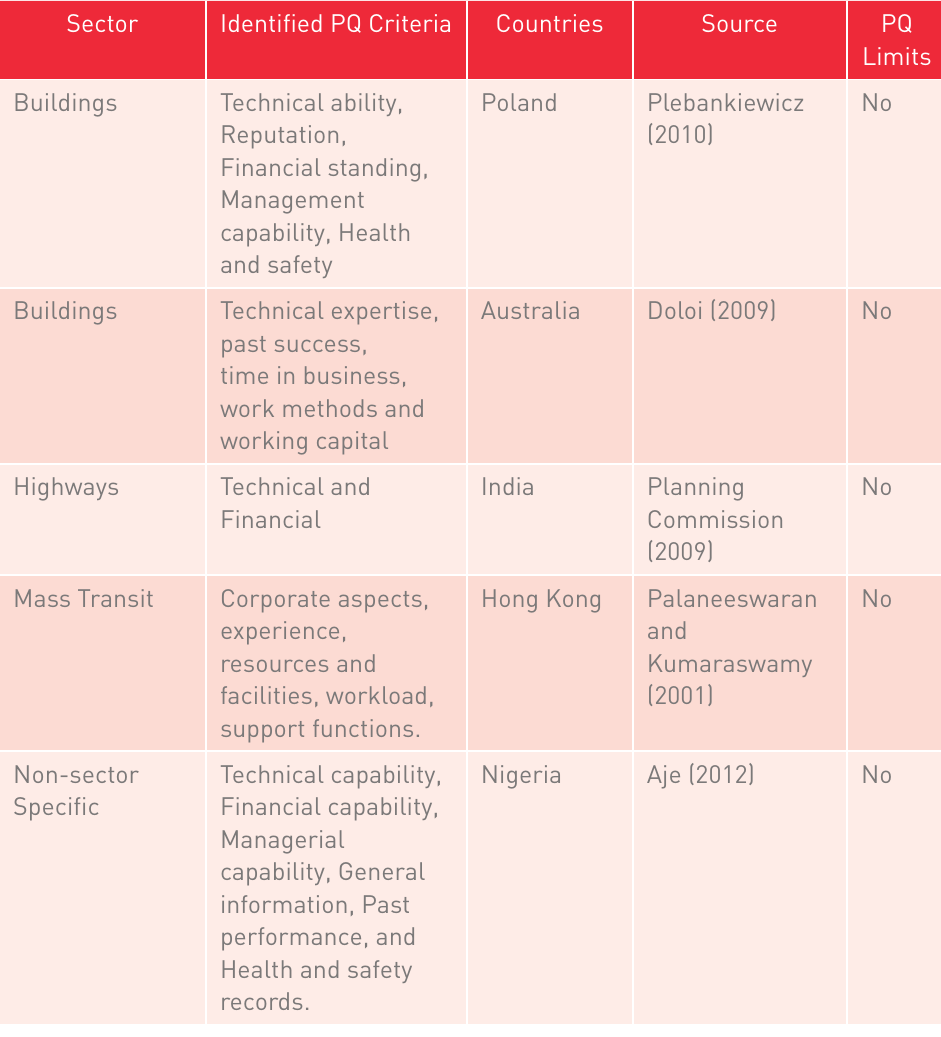
Prequalification criteria in infrastructure transactions Sector Identified PQ